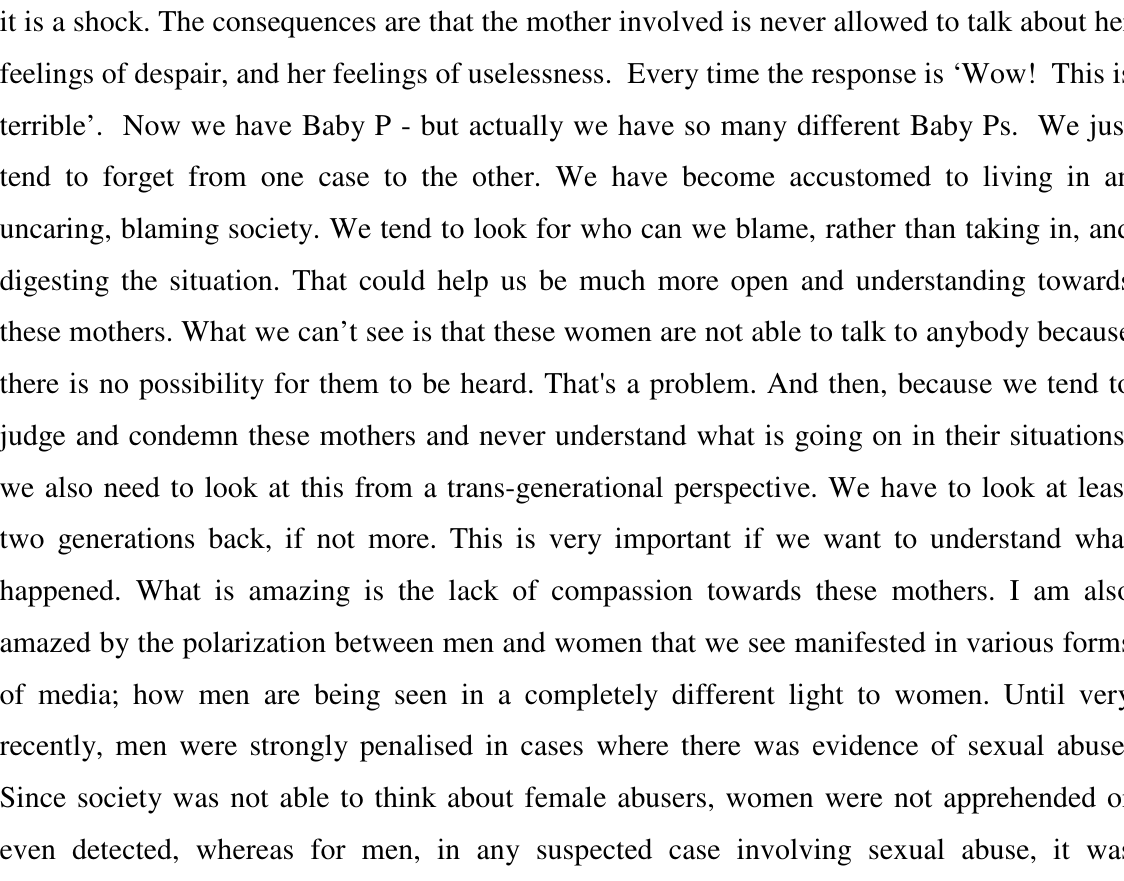
Introduction Sigal Spigel and Lisa